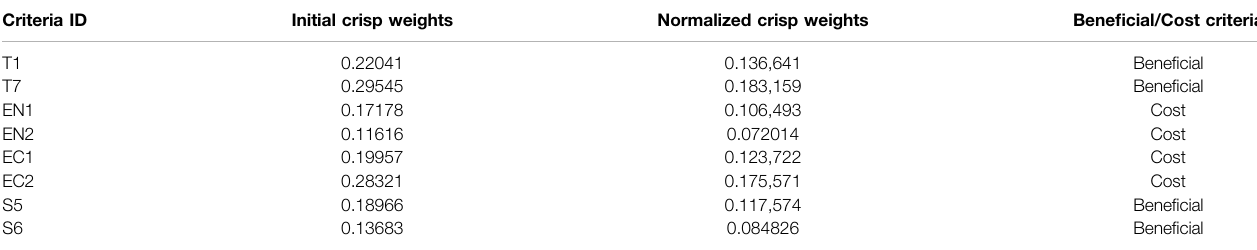
TABLE 7 | Initial crisp weights and normalized crisp weights used in Fuzzy TOPSIS. Criteria ID